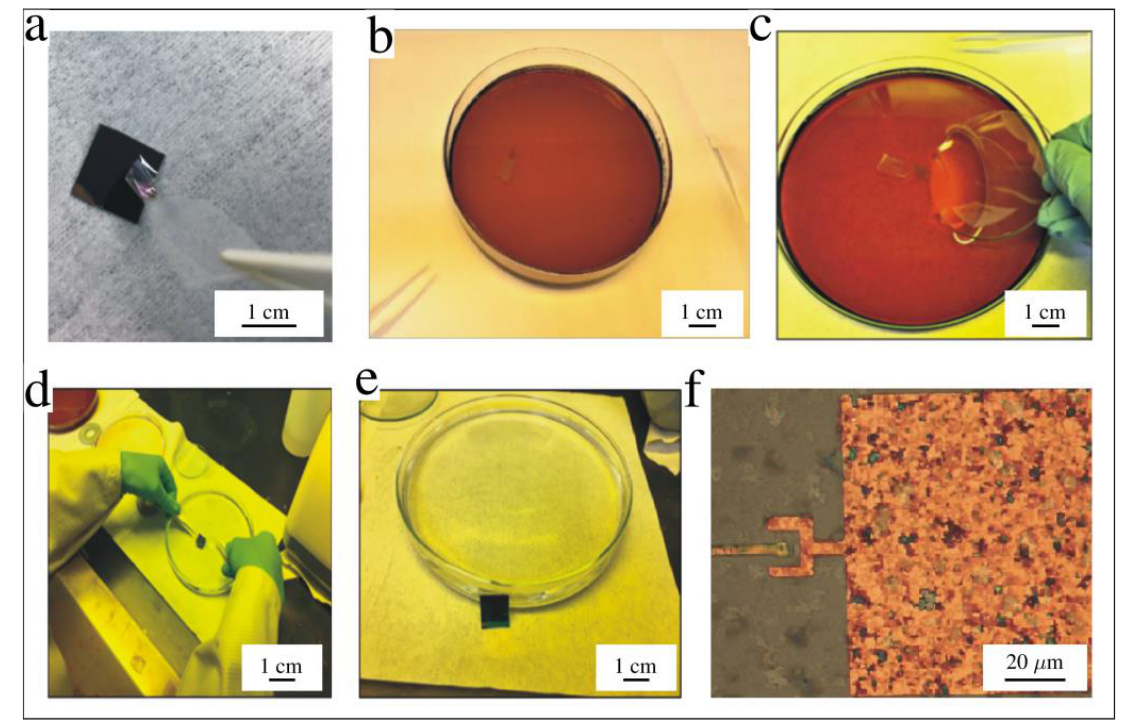
Figure 11. Images of graphene transfer process: ( a ) tape used to peel off a thin strip of Ni-graphene- PMMA layer; ( b ) nickel-graphene-PMMA layer in FeCl 3 solution to etch off nickel; ( c ) watch glass used for scooping graphene; ( d ) aligning graphene to the tip regions of the device; ( e ) placing the sample at an angle for graphene-PMMA layer to stick to the sample; and ( f ) optical image showing graphene location on the device.